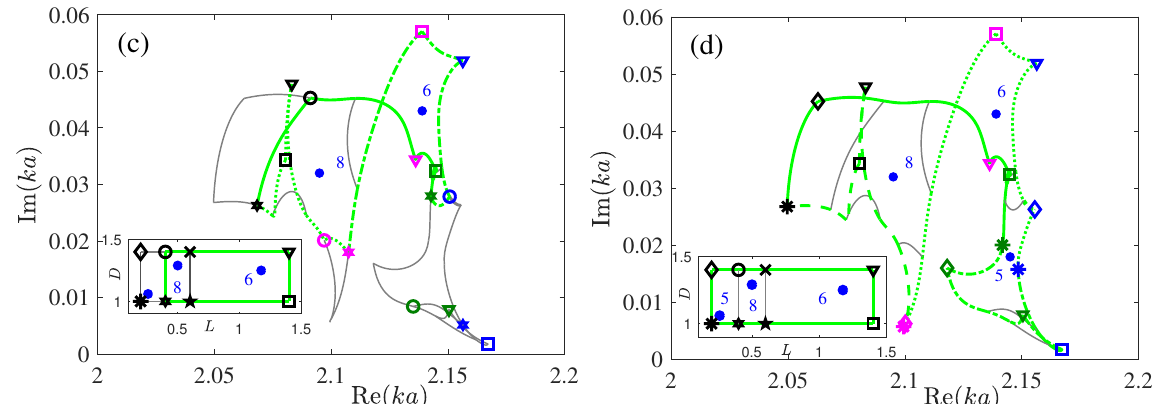
Figure 6. ( a – d ). Evolution of the eigenfrequencies of four disks for encircling in the two-dimensional parametric space L , D shown in the insets. Each turn in the rectangular contour with corresponding markers was mapped into the same markers in the ka space.